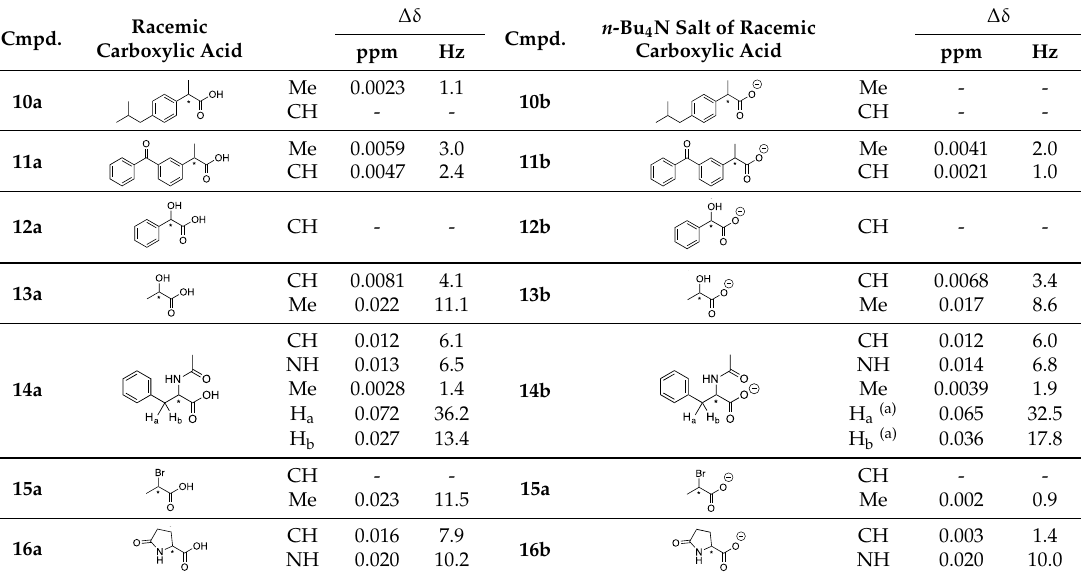
Table 3. The magnitude of non-equivalences ( ∆ δ ) of five racemic carboxylic acids in the presence of 5 and their n -Bu 4 N salts in the presence of 6 ( 1 H-NMR (500 MHz) in CDCl 3 at 27 ˝ C). The experiment was performed by adding a solution containing CSA (46.6 mM, 22.5 µ L, 1.0 eq) to a solution of the guest (2.0 mM, 0.5 mL, 1.0 eq) (- indicates resolution was not detected).